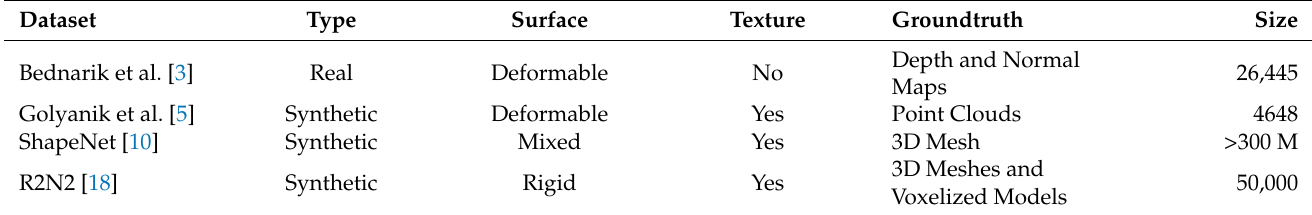
Table 1. Summary of the major 3D datasets in this paper. Most of the datasets contain textured surfaces and are generated from synthetic 3D models. Real datasets captured directly with 3D sensors are less common and smaller in size because of the difficulty associated with obtaining them.